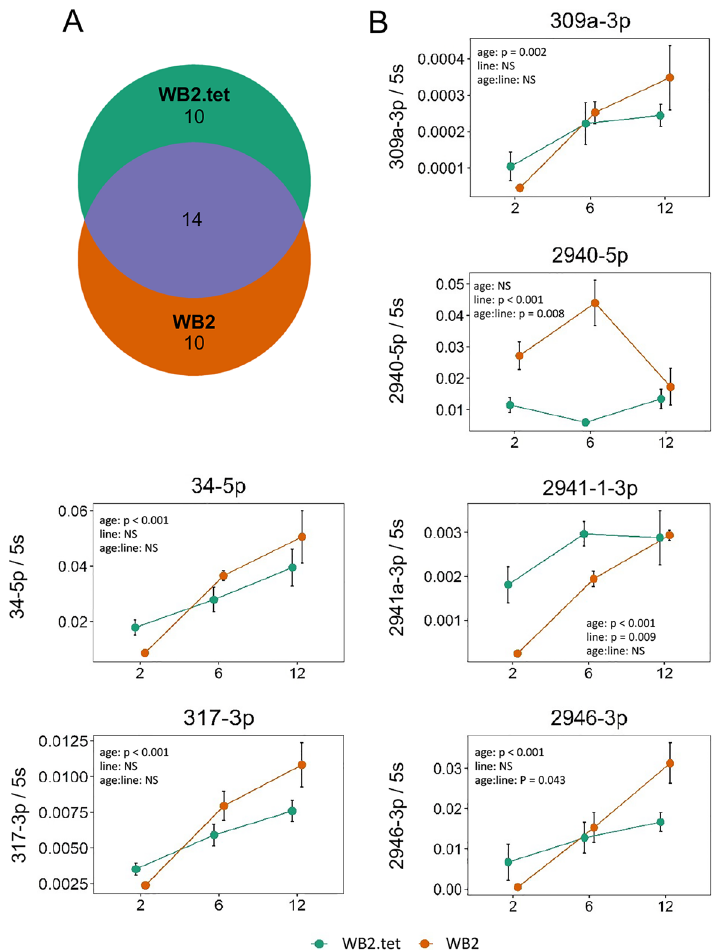
Figure 5. Expression of Ae. aegypti miRNAs increasing with age. ( A ) Venn diagram showing overlap in significantly differentially expressed miRNAs between two mosquito lines. 14 out of 34 miRNAs (41%) were differentially expressed with age in both WB2 and WB2.tet mosquitoes. ( B ) Graphs showing results of RT-qPCR of six miRNAs that showed significant differential expression between age groups according to RNA-Seq. Points are averages of three biological replicates. Error bars represent standard error of the mean. Significant difference between means was estimated using a factorial ANOVA (p < 0.05). NS, not